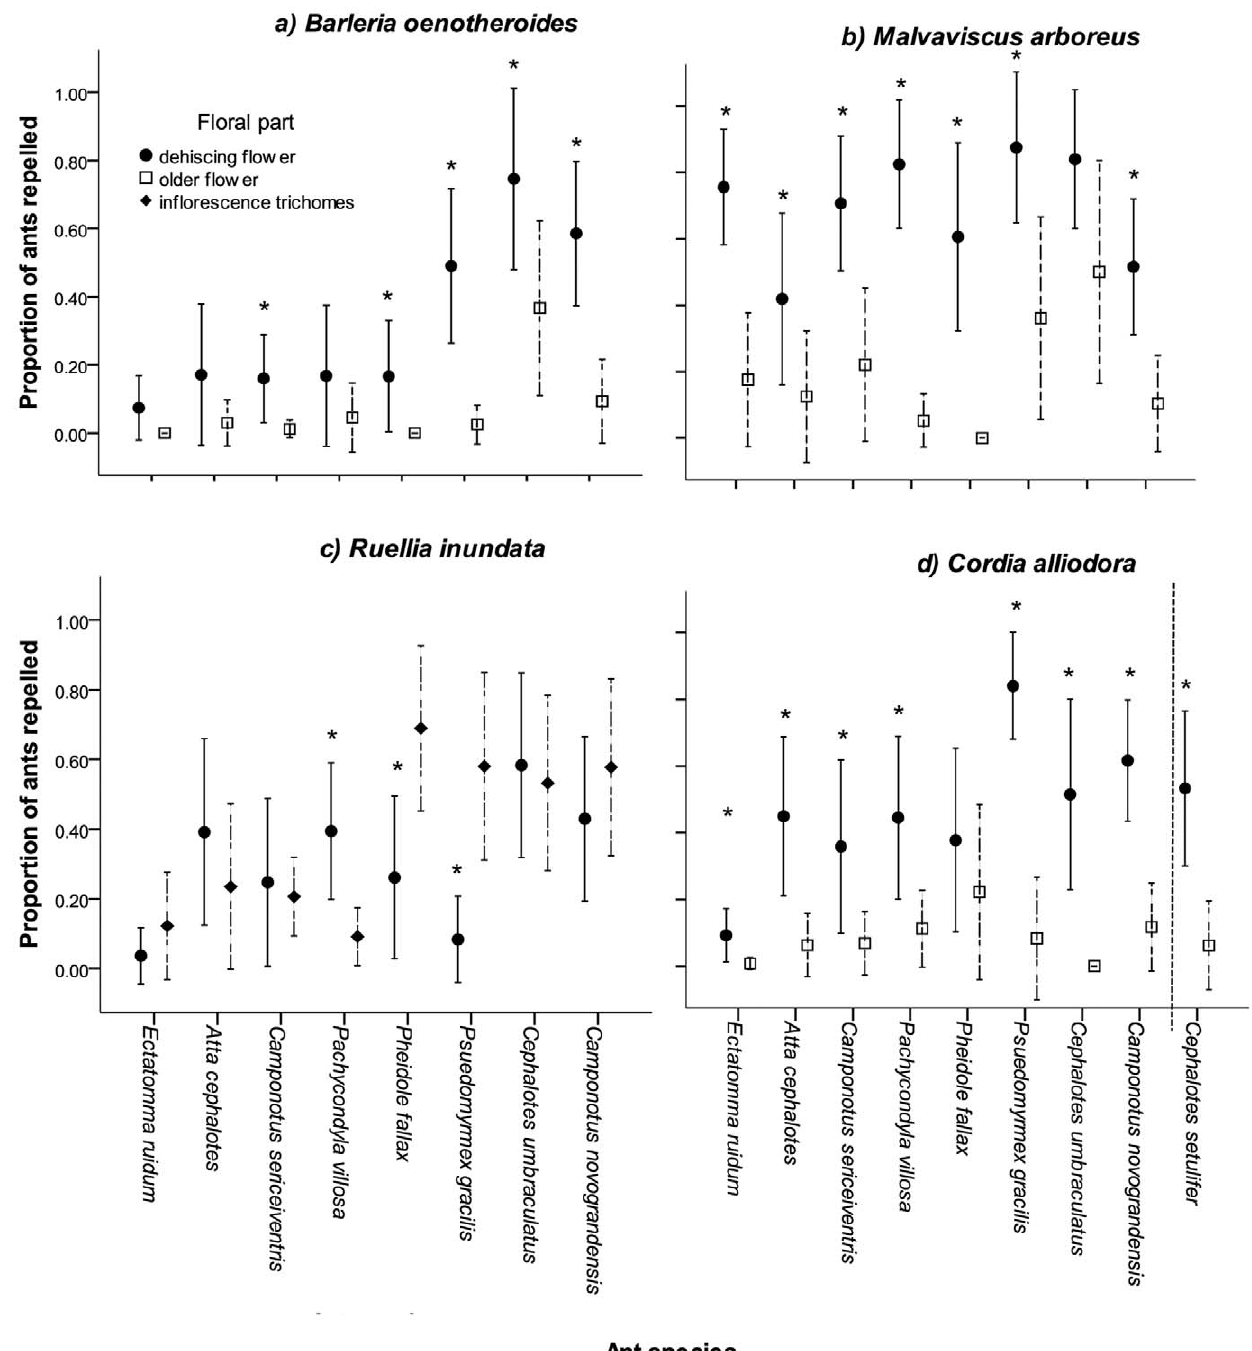
Figure 4. Floral ant-repellence in flowers tested against a range of ant species (including Cephalotessetulifer tested only with its host C.alliodora ). (a) Barleria oenotheroides , (b) Malvaviscus arboreus, (c) Ruellia inudata and (d) Cordia alliodora. * indicates significant difference between freshly dehisced flowers and old pollen-depleted flowers. Error bars indicate 95% confidence intervals.